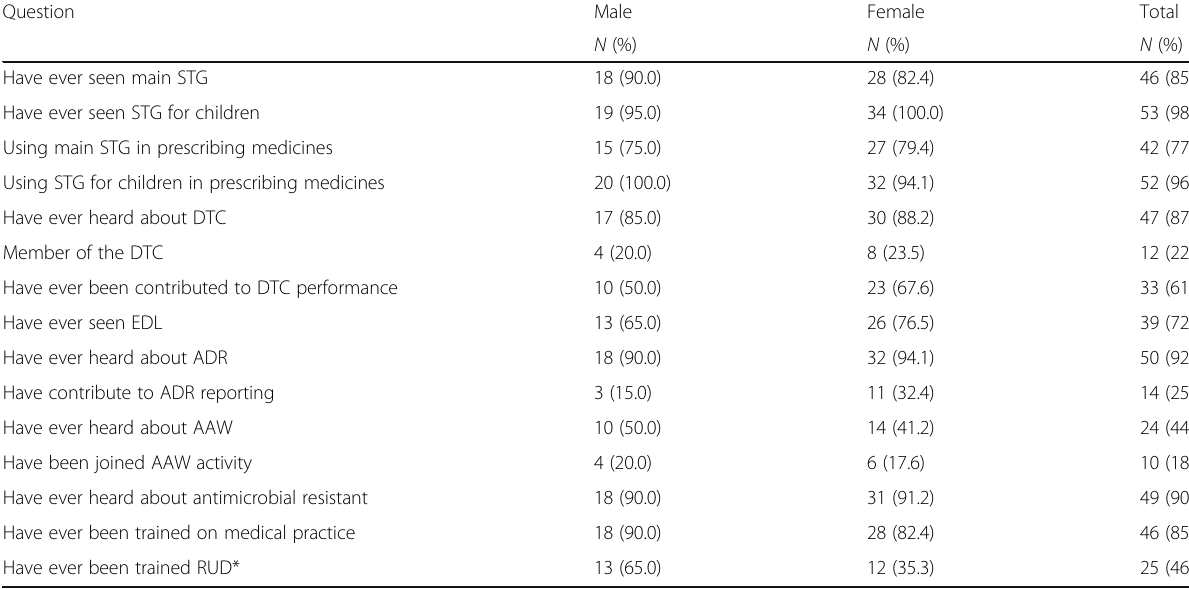
Table 2 Knowledge of healthcare providers (20 males and 34 females): those who answered “ yes ” to each question Question